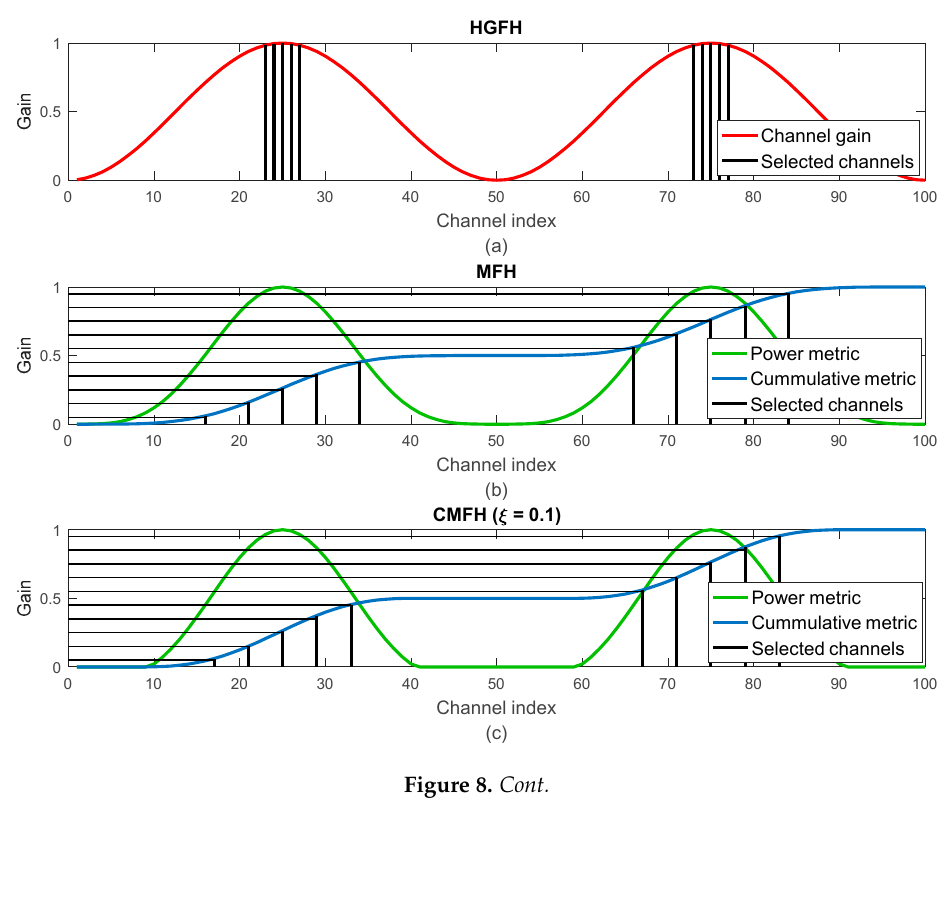
Figure 8. Comparison of channel selection between different frequency hopping techniques: ( a ) Highest Gain Frequency Hopping (HGFH); ( b ) Matched Frequency Hopping (MFH); ( c ) Clipped Matched Frequency Hopping (CMFH) with (cid:2022) = 0.1 ; ( d ) Advanced Frequency Hopping (AFH) with (cid:2009) = 0.1 . The selected channels are represented as vertical black lines. HGFH directly uses the channel gain (red) to select the best channels, while MFH, CMFH and AFH use the cumulative metrics (blue) obtained from the power metrics (green) and their intersections with the equally spaced horizontal lines.